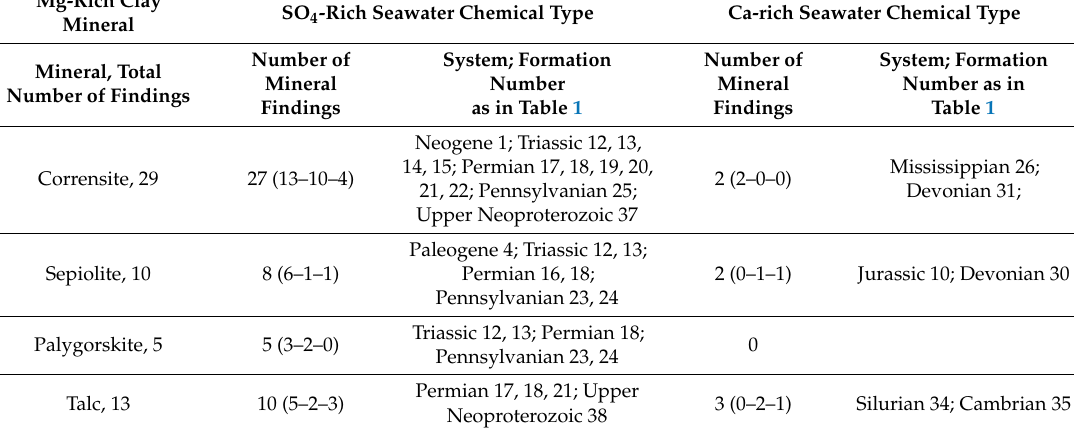
Table 4. Occurrence of magnesium-rich clay minerals of Phanerozoic evaporite deposits formed from concentrated SO 4 -rich and Ca-rich chemical types of seawater. In brackets the number of findings in deposits formed at di ff erent stages of concentration (sulfate-carbonate—halite—potassium salts) is